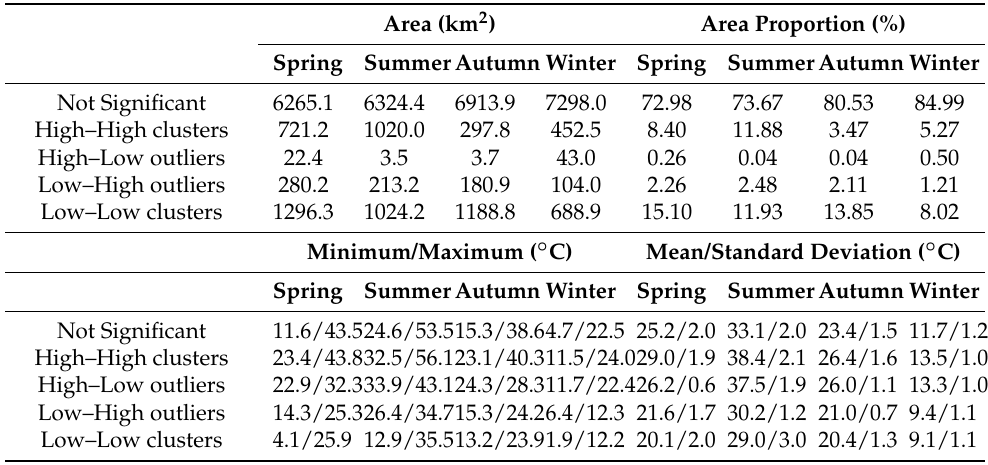
Table 2. Descriptive statistics, area, and area proportion of the LST clustering features shown in Figure